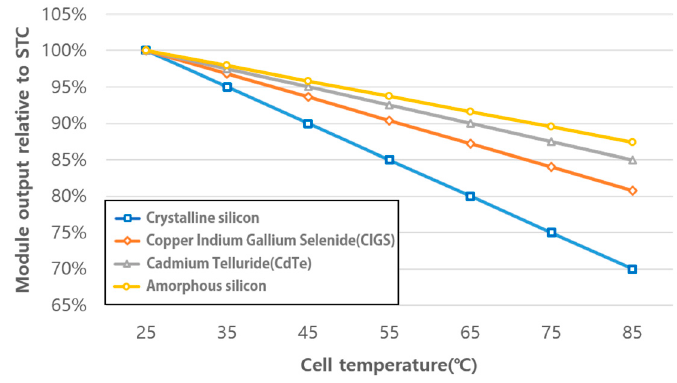
Figure 2. The effect of cell temperature on PV module performance [8].